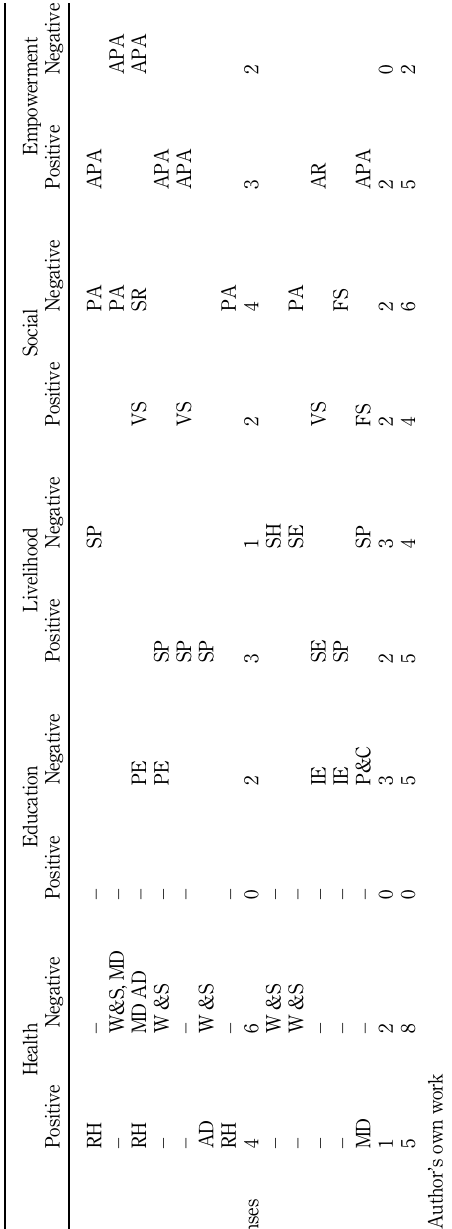
Table 2. Outcomes of the photovoice process (positive and negative